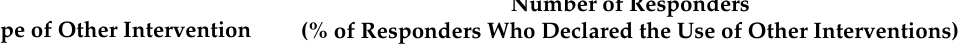
Table 2. Overview of types of other interventions used by pediatricians to address the problem of infantile